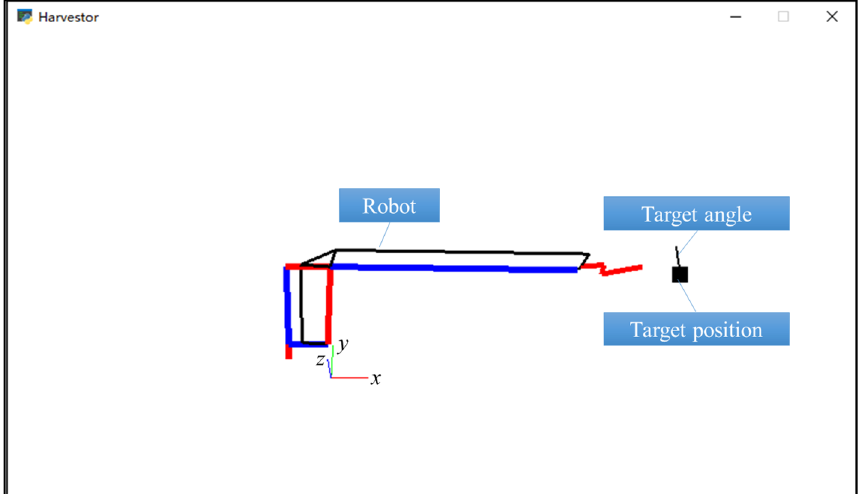
Figure 5. Simulation environment.